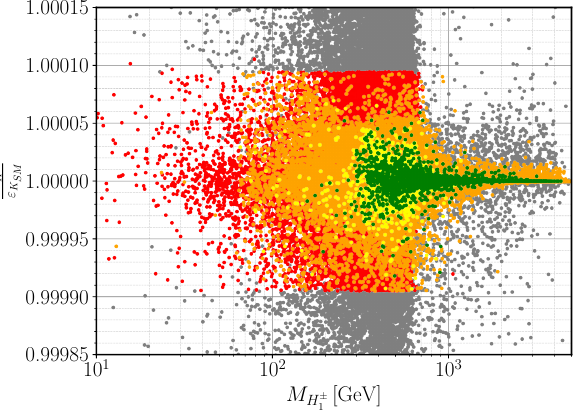
mass for the parameter space allowed under several constraints Figure 5 . (cid:15) K as a function of the H ± 1 imposed on the BGL-like 3HDM. The colour code is the same as in figure